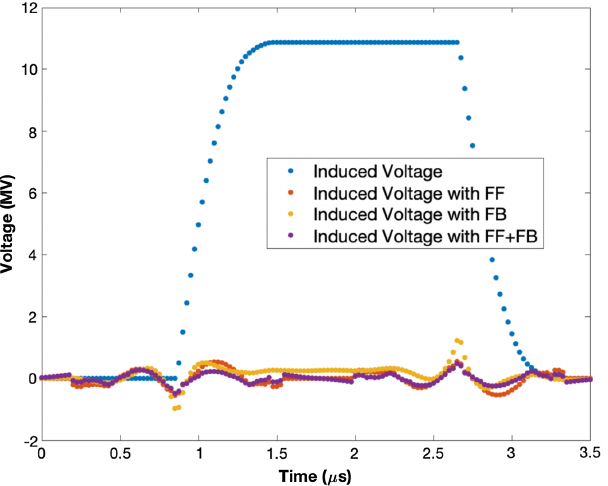
FIG. 9. Transmitter power for four-section cavity.